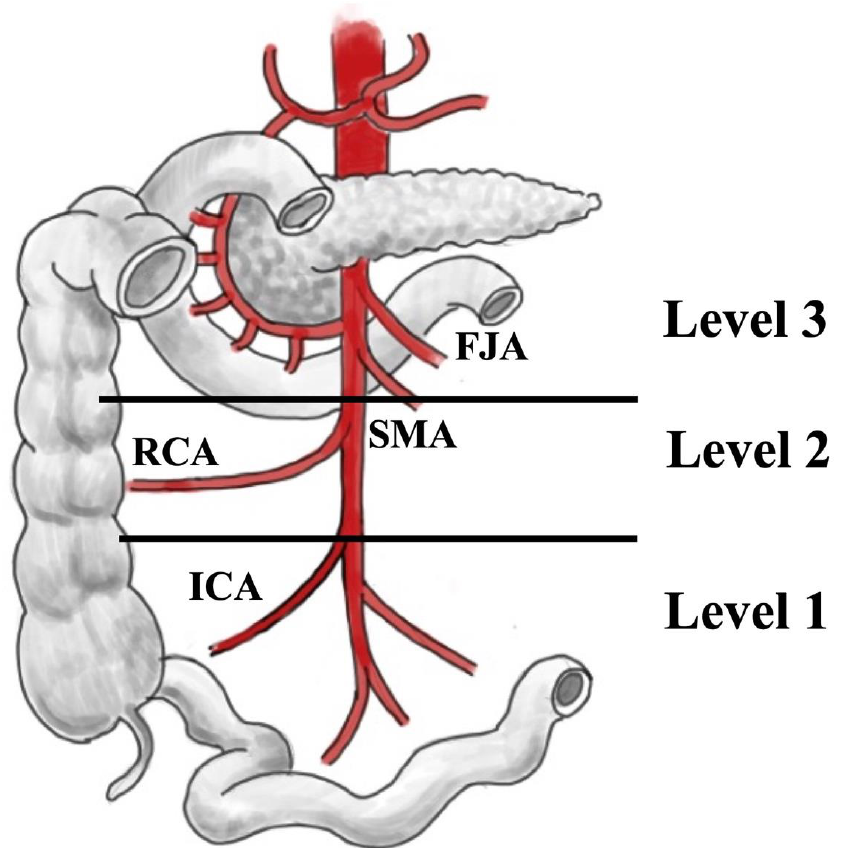
Figure 1. Levels of locoregional lymph node involvement in SI-NENs (modified based on Ohrvall et al. [7]). SMA — superior mesenteric artery; ICA — ileocolic artery; RCA — right colic artery; FJA — Ohrvall et al. [7]). SMA—superior mesenteric artery; ICA—ileocolic artery; RCA—right colic